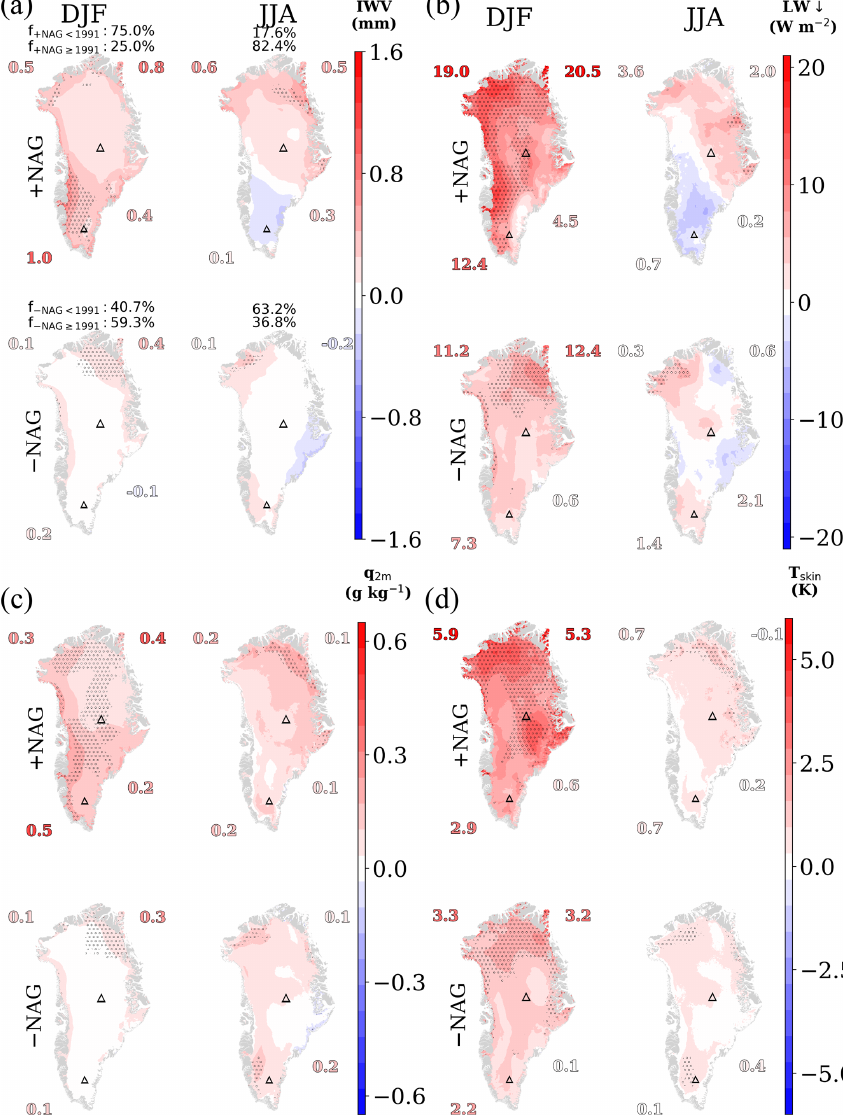
Figure 5. Seasonal and spatial anomalies for (a) integrated water vapor, (b) incoming longwave radiation reaching the surface, (c) near- surface specific humidity and (d) skin temperature from RACMO2 between 1991–2020 and 1959–1990 as dependent on the NAG phase. The percentage ( f ) of the NAG phase in each period is indicated for each season. For reference, Summit and South Dome are marked as big and small triangles, respectively. Stippled regions indicate areas with a confidence level greater than 90% (based on the Wilcoxon rank-sum statistic test for unpaired sets). Temporal anomalies between composites over the adjacent seas are also shown as colored numbers (Baffin Bay: upper left; Greenland Sea: upper right; Irminger Sea: lower right; Labrador Sea: lower left). Temporal anomalies equal to null are omitted. See Fig. S1 to discern the extension overseas and Fig. S9 to examine seasonal and spatial anomalies under